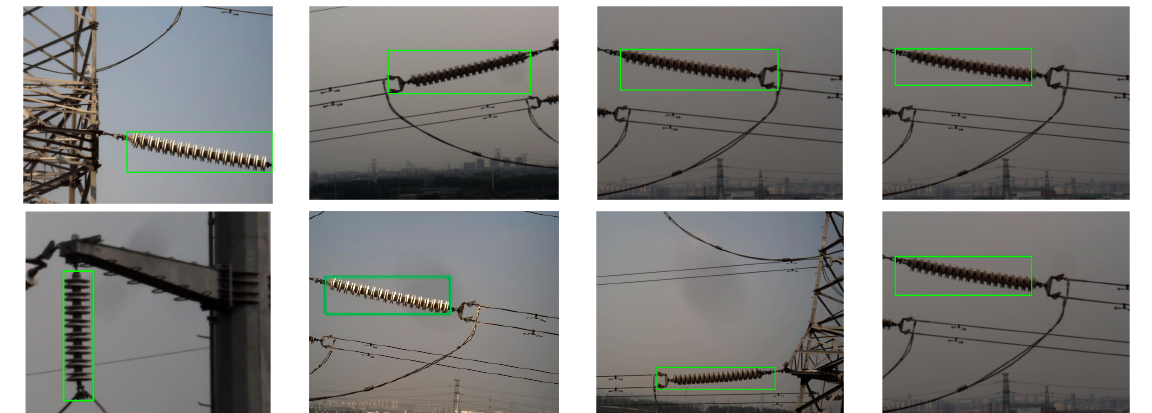
Figure 12. Detection examples of a single insulator.